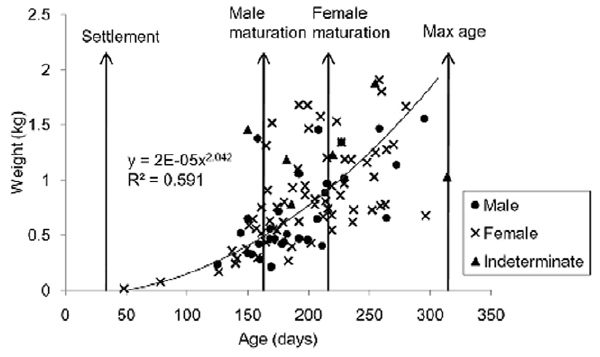
Figure 1. Growth and life cycle of Octopuscyanea . Weight at age fitted with a power growth trajectory showing summarised life cycle of Octopus cyanea (n=102) including proposed age at settlement, sexual maturity for each gender and maximum age in days. The 30 d settlement estimate is based on an abrupt change in the spacing of rings bordered by a darker ring in the stylet.